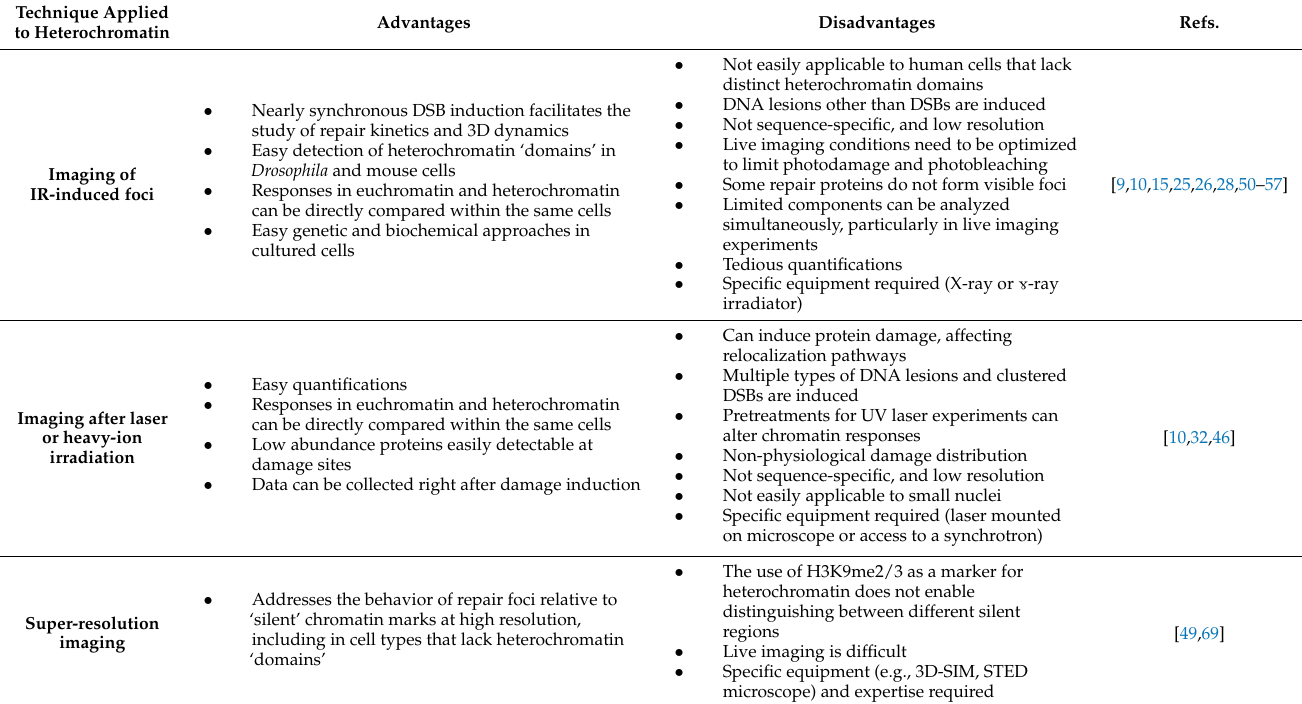
Table 1. Summary of techniques available to study heterochromatin repair, including main advan- tages and